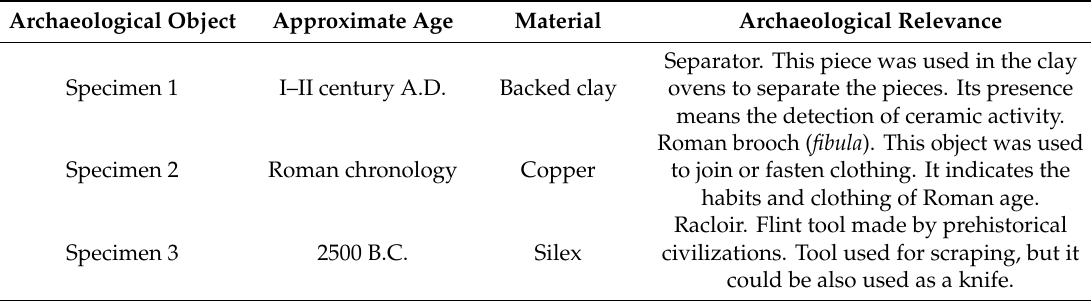
Table 2. Technical specifications of the photogrammetric system. CMOS: Complementary Meta Oxide Semiconductor.